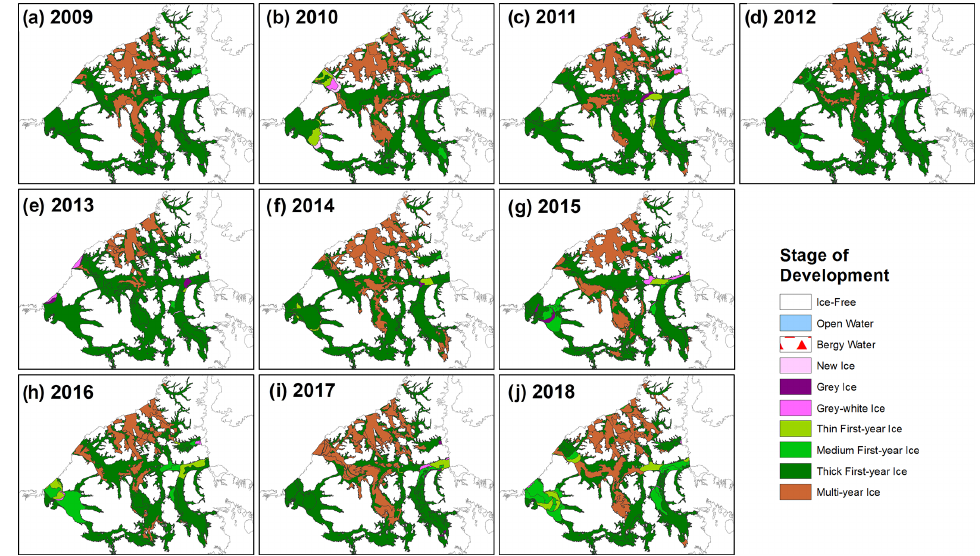
Figure 4. Spatial distribution of sea ice stage of development (type) in the first week of April in the Canadian Arctic Archipelago for 2009–2018 (a–j)